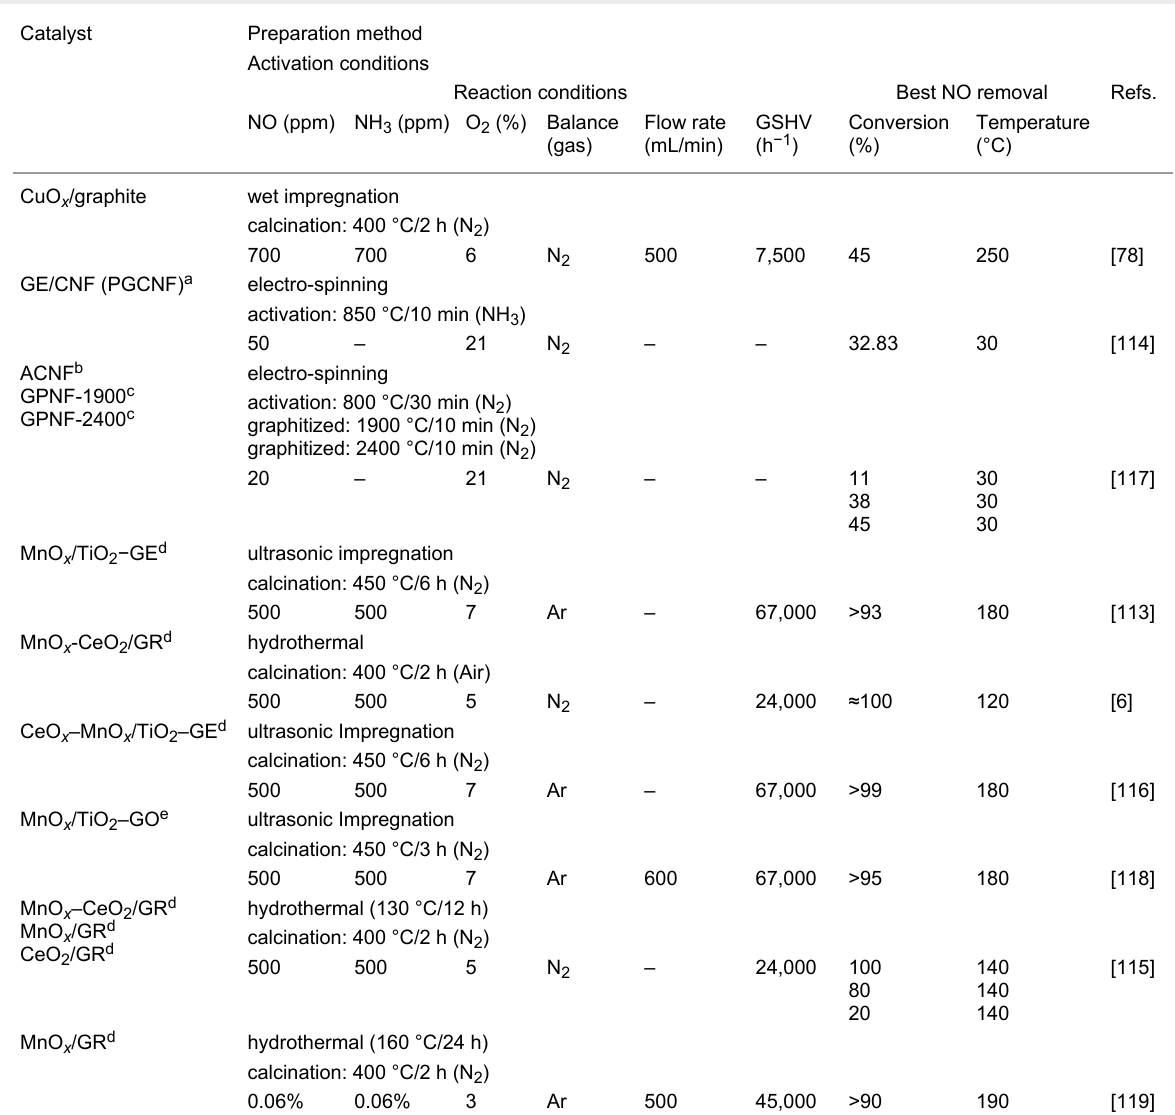
Table 4: Summary on the reaction conditions and NO activity for graphene supported based